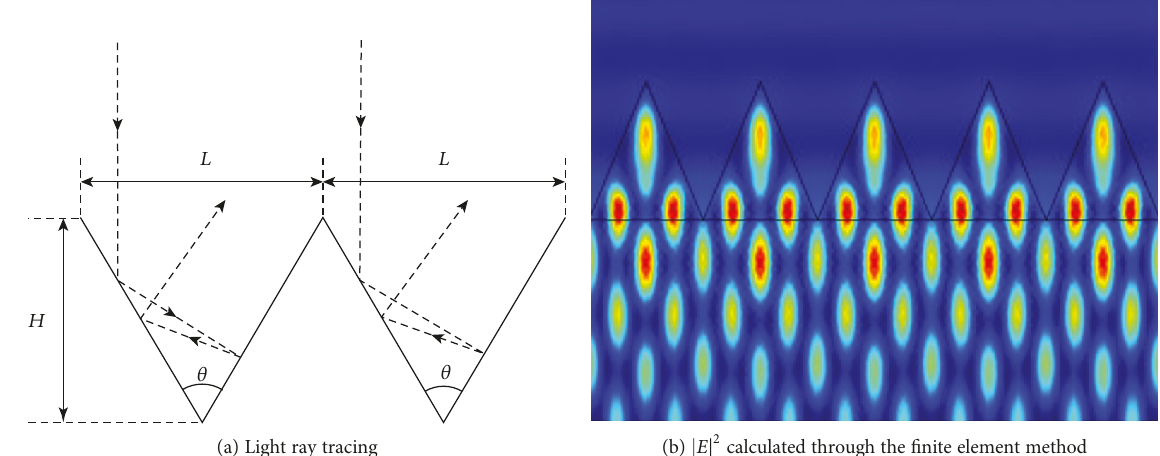
Figure 2: Surface structure of V-type groove and light fi eld